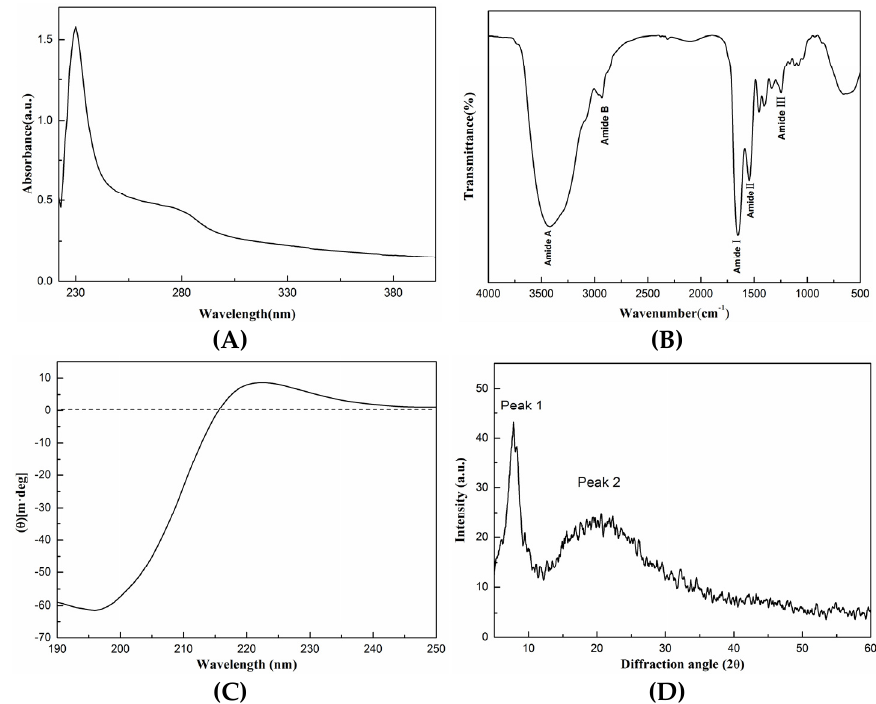
Figure 2. Spectral analysis of SCSC. ( A ) UV; ( B ) FTIR; ( C ) CD; ( D )